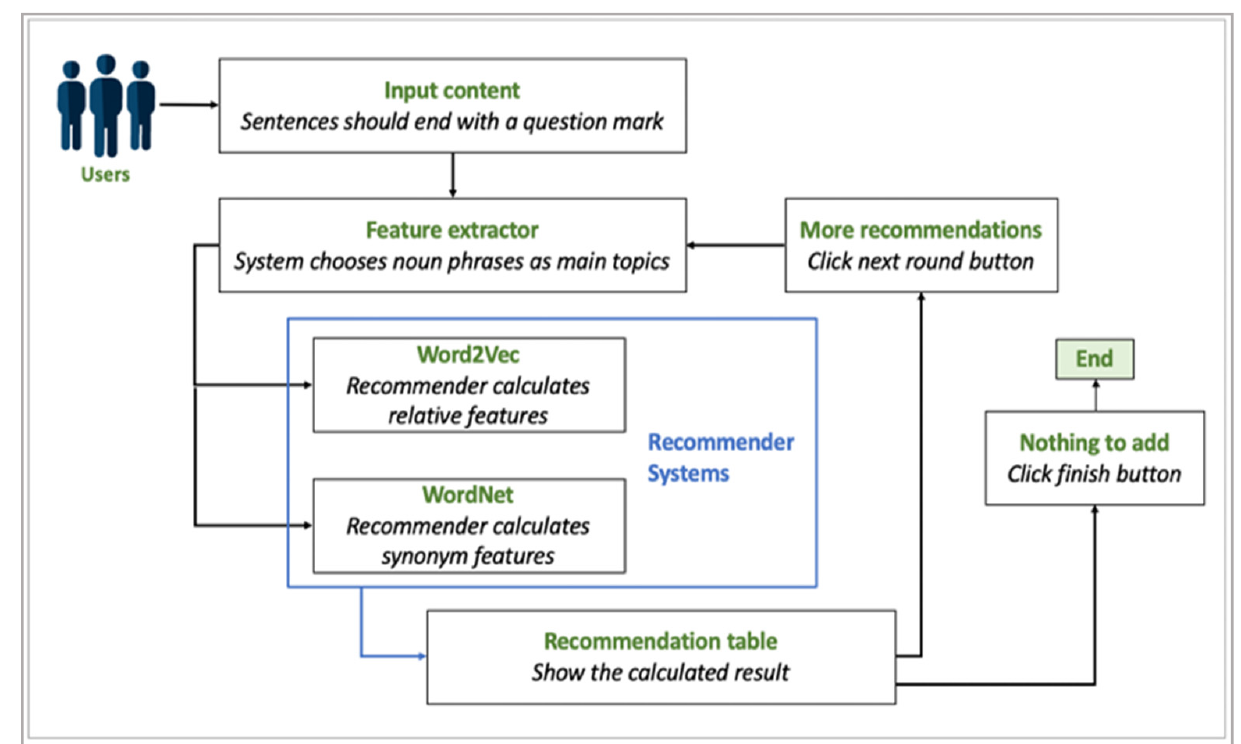
Figure 2. User perspective of interactive data flow.